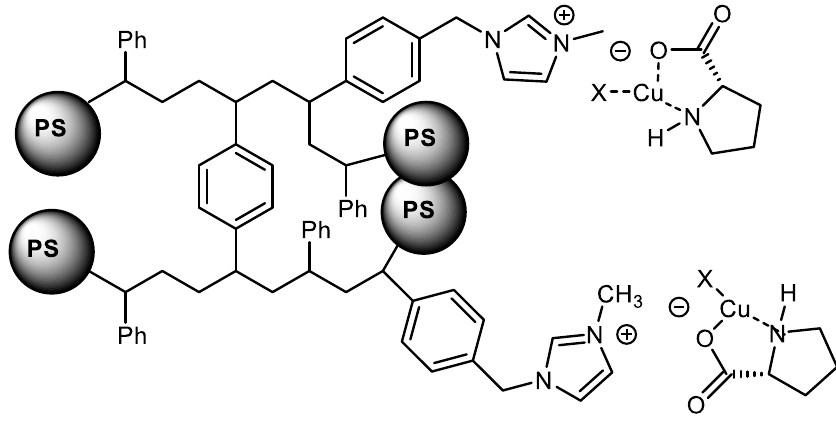
Figure 7. Proposed structure of PS-supported MIM.L-proline-based-Cu-catalyst [104]. Catalysts 2022 , 12 , x FOR PEER REVIEW 21 of